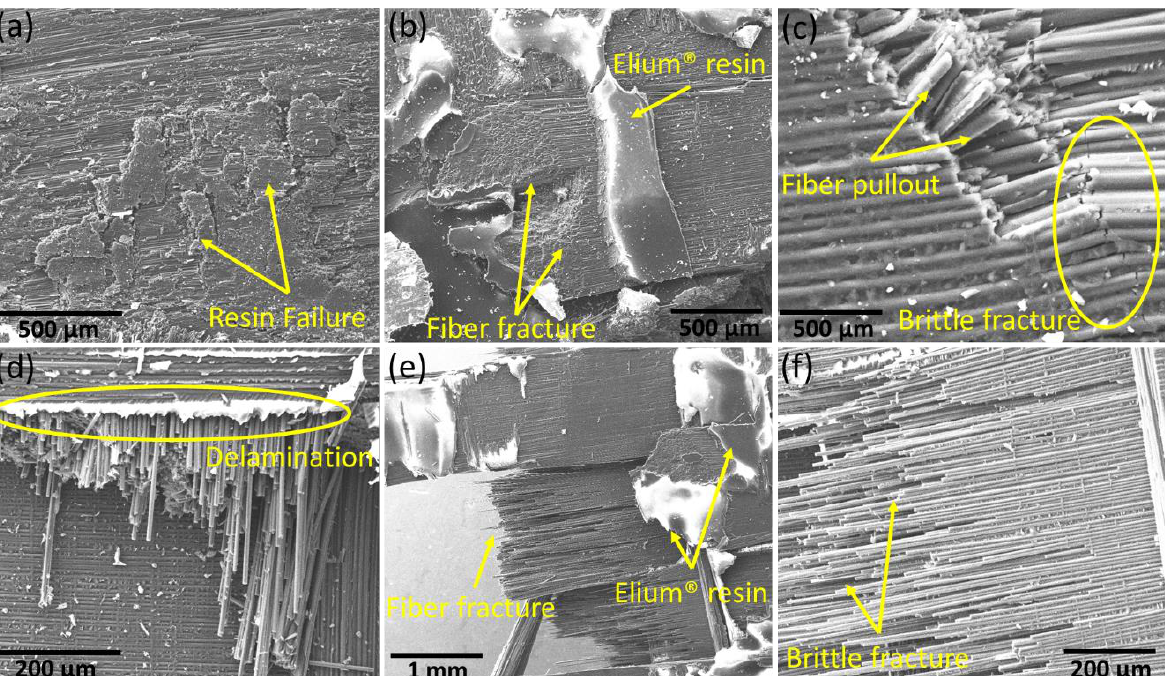
Figure 11. SEM micrographs showing different failure modes in the samples repaired at 210 °C after flexural testing ( a – c ) Type A and ( d – f ) Type B specimens. flexural testing ( a – c ) Type A and ( d – f ) Type B